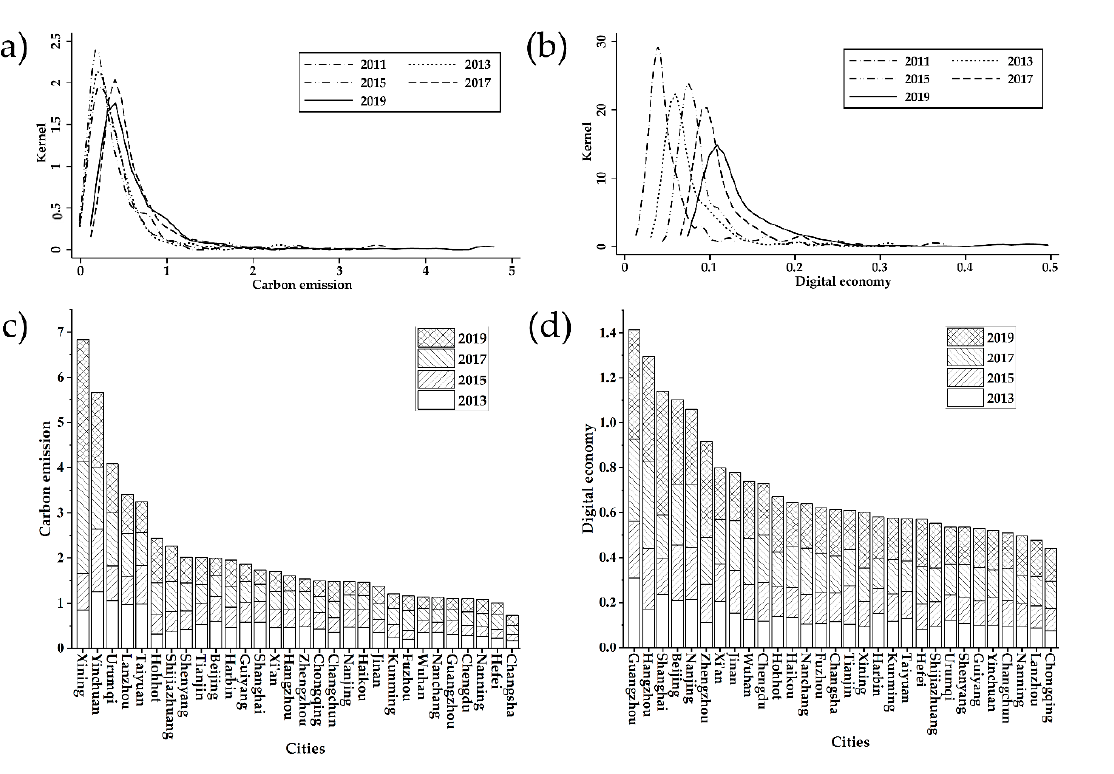
Figure 2. Spatial and temporal distribution of carbon emission intensity and digital economy. ( a ) The kernel density superposition of carbon emission intensity; ( b ) The kernel density superposition of digital economy; ( c ) The level of carbon emission intensity in China’s provincial capital cities and municipalities; ( d ) The development level of the digital economy in China’s provincial capital cities and municipalities.